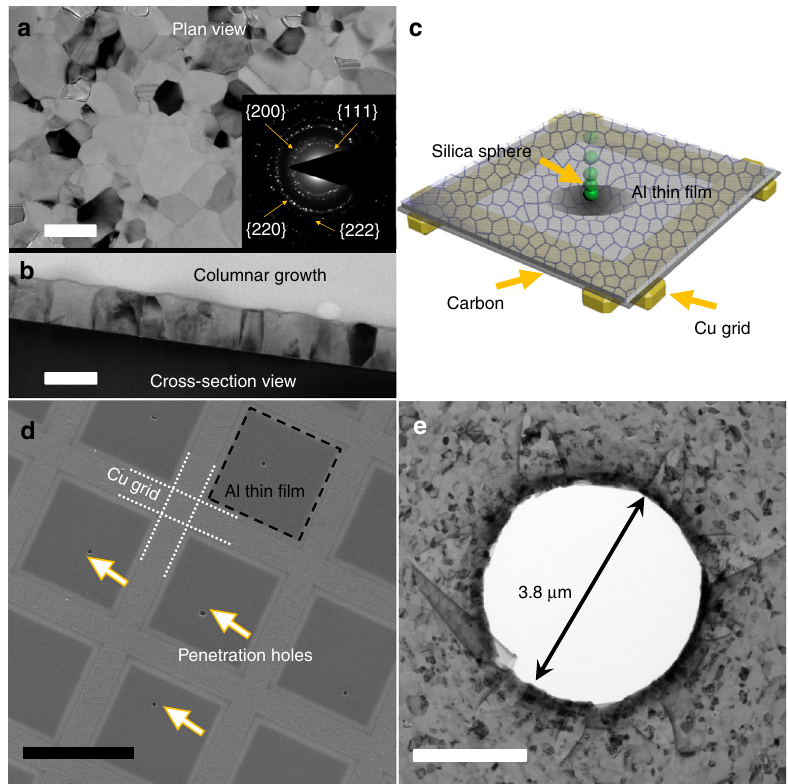
Fig. 2 A laser-induced projectile impact testing ( α -LIPIT) for UFG Al fi lms with a thickness of 140 nm. a A plan-view TEM micrograph showing the as-deposited UFG Al fi lm. Scale bar, 200 nm. b The cross-sectional view of the as-deposited Al thin fi lm showing columnar grains. Scale bar, 100 nm. c A schematic of the α -LIPIT experiment. d A low magni fi cation SEM micrograph showing the perforations induced by micro-projectiles in the UFG Al fi lm supported by Cu TEM grid. Scale bar, 100 µ m. e A representative TEM image showing the fi lm morphology around a circular perforation. Scale bar, 2 µ